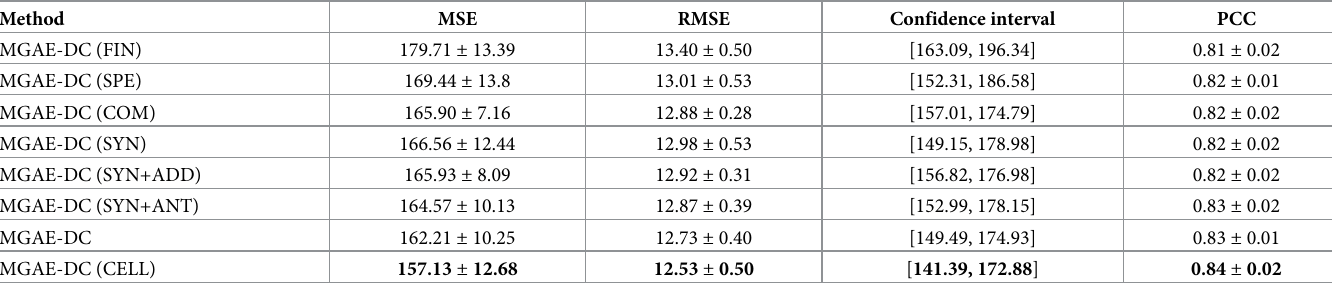
Table 3. The results of the ablation